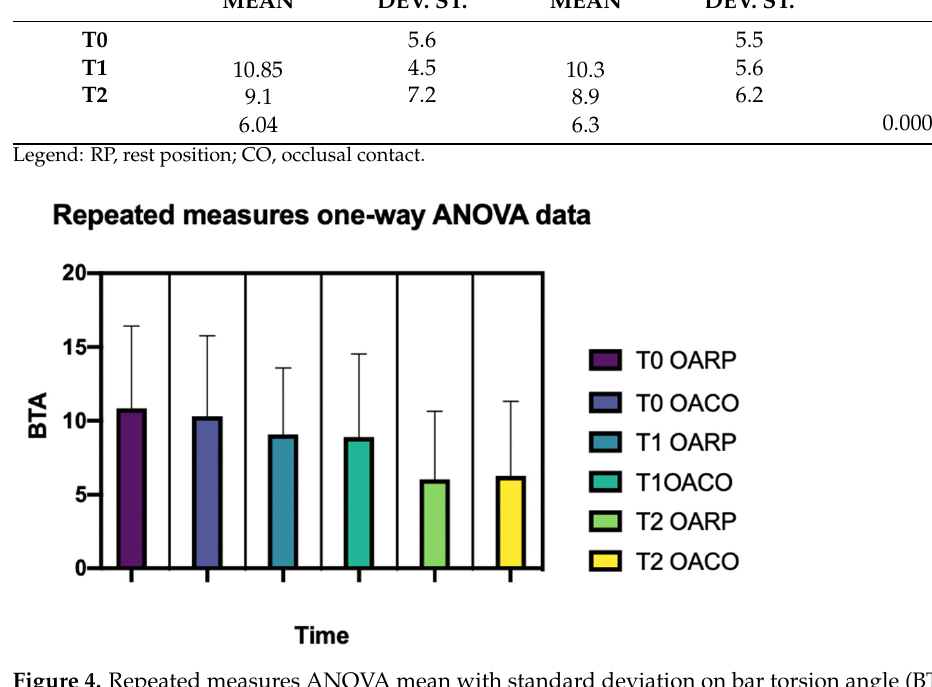
Figure 3. Repeated measures ANOVA mean with standard deviation on weight distribution (WD). Table 3. Repeated measures ANOVA test on bar torsion angle (BTA).